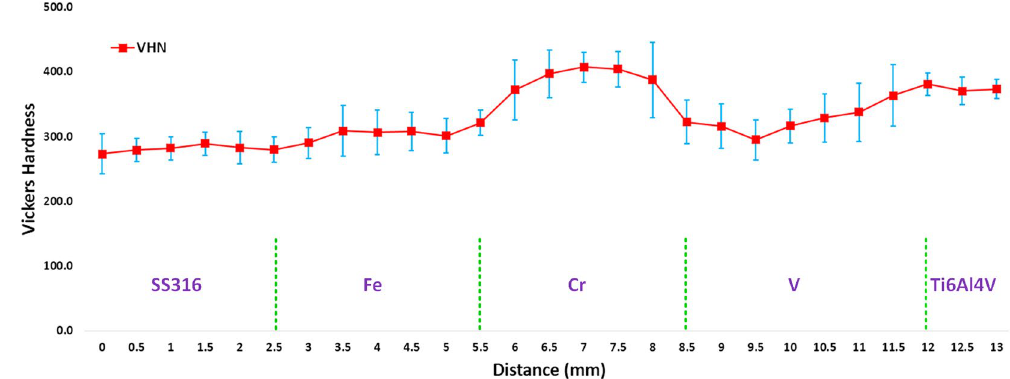
Figure 15. Vickers hardness result along the route.